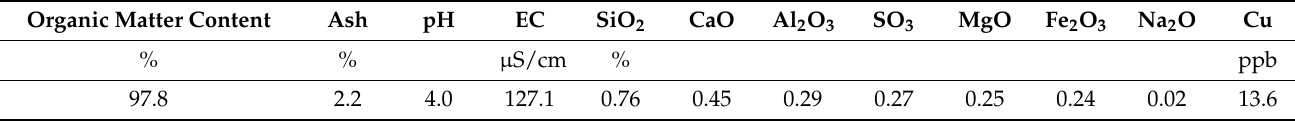
Table 1. Physical and chemical properties of peat, pH, and EC of the water of the Ubinskoe peat bog. Organic Matter Content